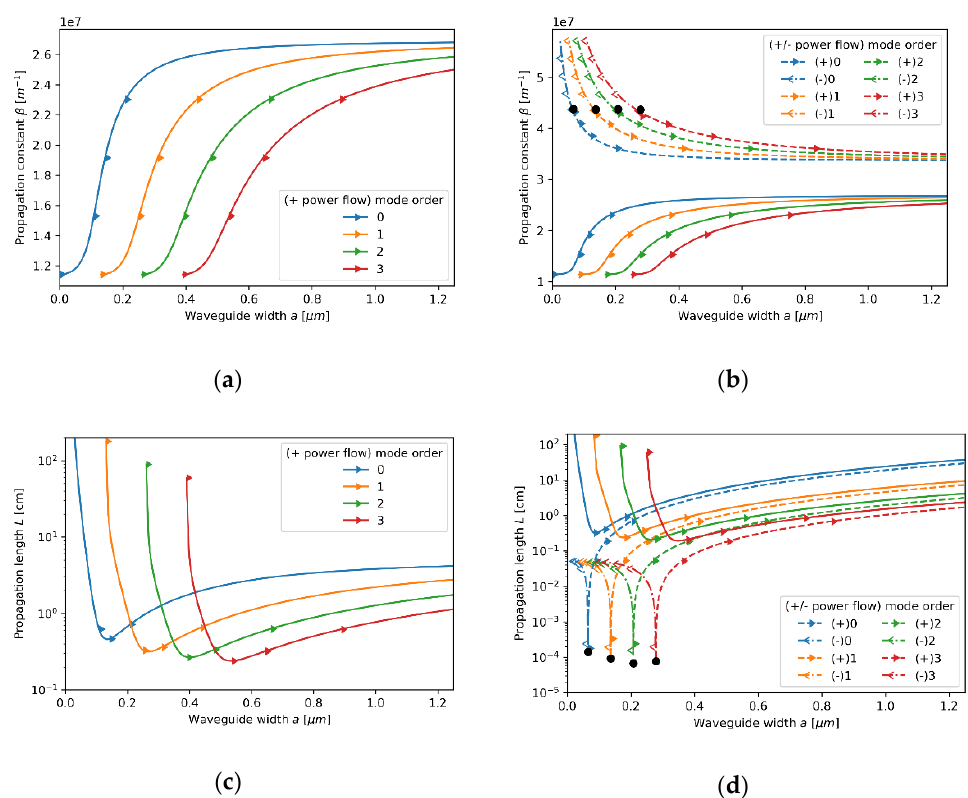
Figure 7. Propagation constant ( a , b ) and propagation length ( c , d ) of TM modes plotted versus waveguide width for an HMM waveguide with Nb2O5 layer of t Nb2O5 = 80 nm embedded in the unit cell and described with local ( a , c ) and nonlocal EMT ( b , d ).